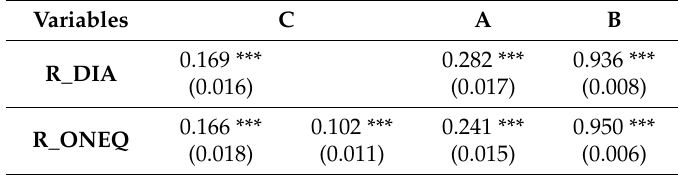
Table 23. Diagonal BEKK for US Market ETF returns (After GFC) (1 April 2009 to 30 March 2015). Variables